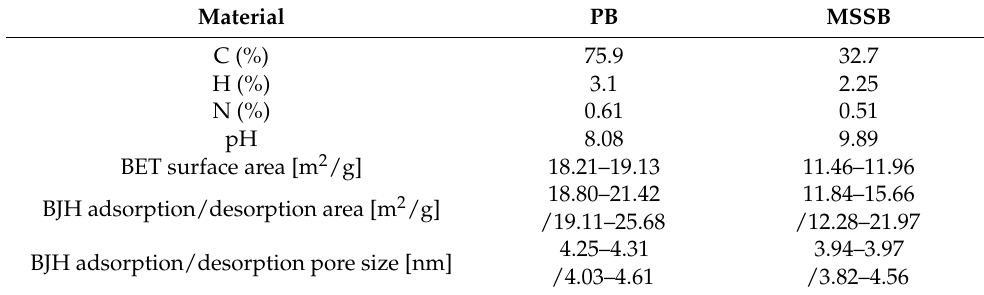
Figure 3. Scanning electron microscope (SEM) images of MSSB and PB: ( a ) MSSB (×550), ( b ) PB (×550), ( c ) energy dispersive X-ray spectroscopy (EDS) analysis of MSSB.